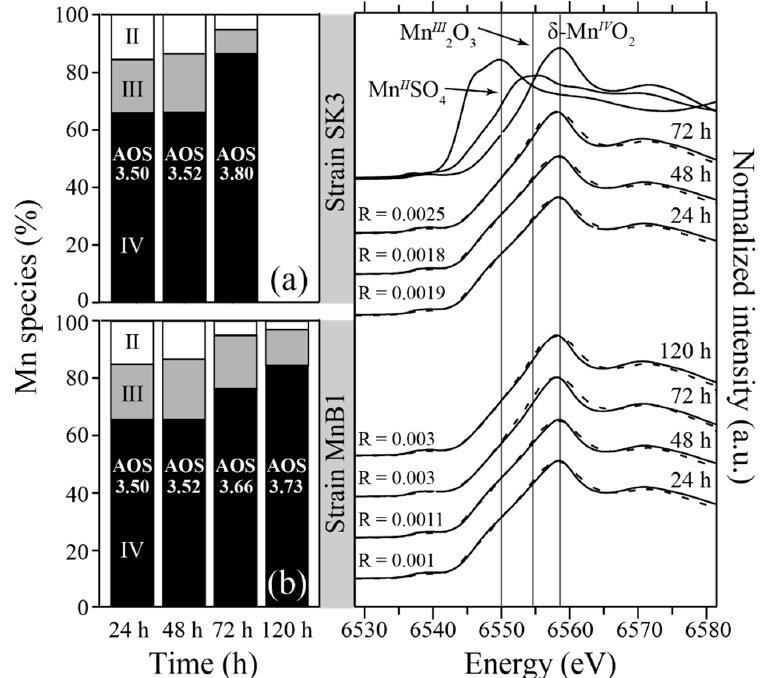
Figure 9. Changes in the Mn AOS of Mn-precipitates produced by isolate SK3 ( a ) or Ps. Putida MnB1 ( b ). The ratios of Mn(II) (white), Mn(III) (grey), and Mn(IV) (black) were calculated from the linear combination fitting result (broken lines) of Mn K-edge XANES spectra (solid lines). Sampling points (24, 48, 72, and 120 h) of the Mn-precipitates correspond to those shown in Figure 5a ( ■ □ , +Cu 2+ ). As Mn standards, Mn II SO 4 , Mn III 2 O 3 , and δ -Mn IV O 2 were used. AOS stands for average oxidation state. Fitting results with R -factors < 0.003 were considered